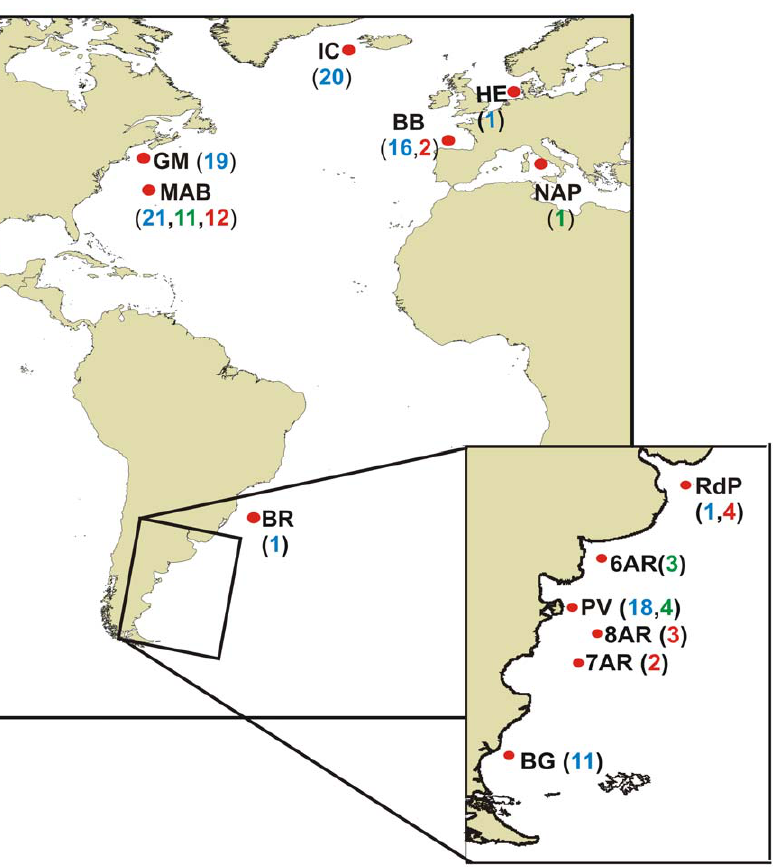
Figure 1. Collection sites and number of specimens in each site for each Oithona species. Specimens of O. similis sampled (in blue); O. nana (green); O. atlantica (red). Explanation of abbreviations for the collection sites are given in Table I and the text.